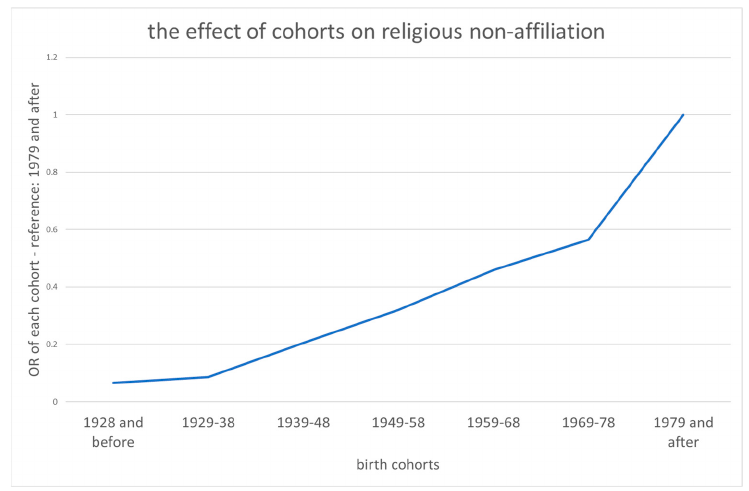
Figure 2. The effects of cohorts on non-affiliation—odds ratios. Non-affiliation is stronger for men (OR of 1.176) compared to women, stronger in cities (1.348), and also increases with the education level (OR of 1.591 for higher education and 1.118 for vocational training, compared to those with primary school education).